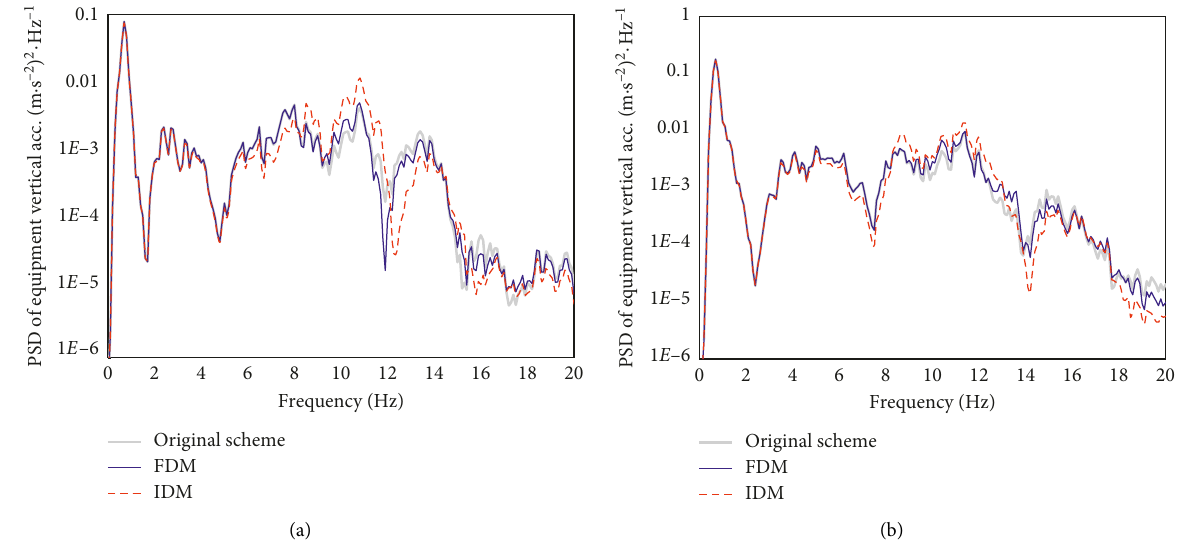
Figure 13: The power spectrum of UCE vertical vibration acceleration. (a) The speed of 200km/h. (b) The speed of